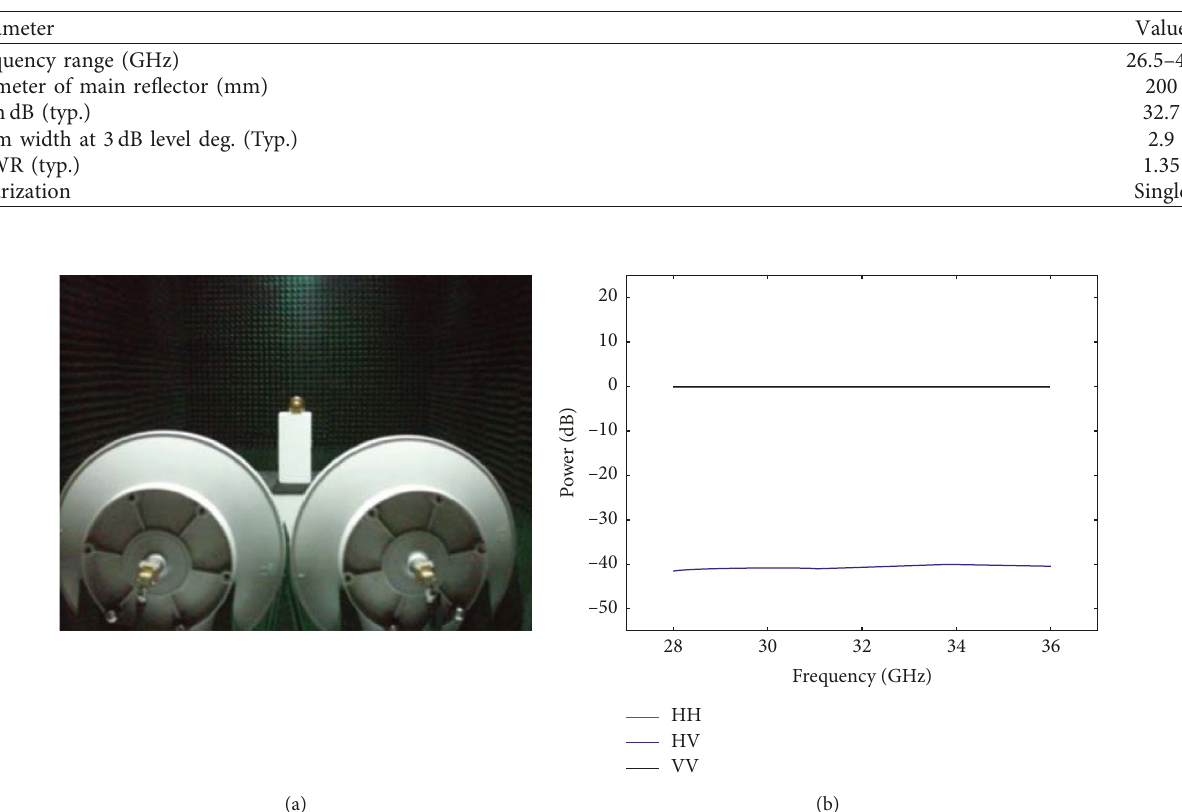
Table 2: Specifications of the Ka-band